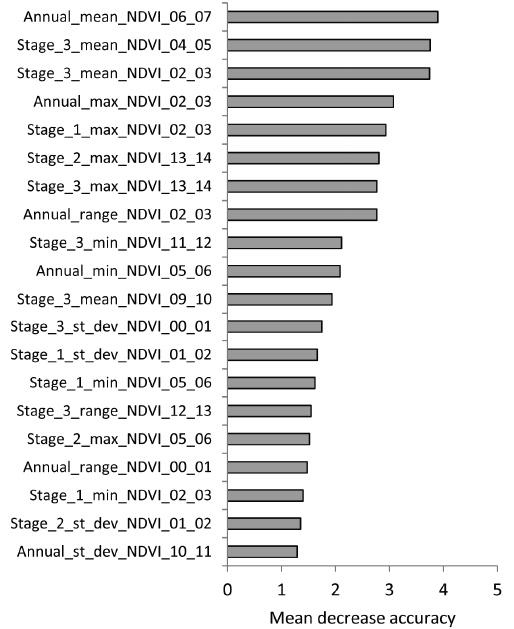
Figure 6. Variable importance plot of 20 most significant variables reported as mean decrease in overall accuracy determined during the OOB error calculation in random forest